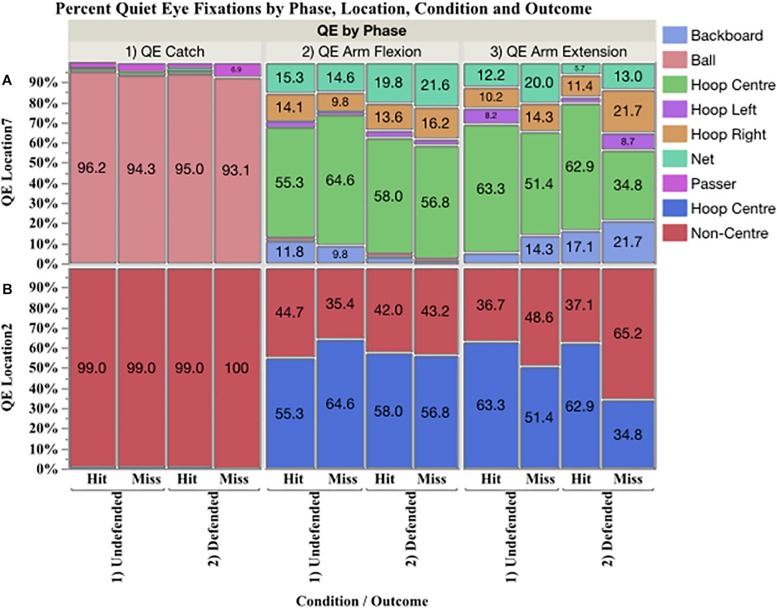
Mosaic plot showing in the top panel (A) the percent of QE fixations to seven locations (QE location 7: backboard, ball, hoop centre, hoop left, hoop right, net, and passer), and in the bottom panel (B) to two locations (QE location 2: hoop centre and non-centre) by phase, condition and outcome.